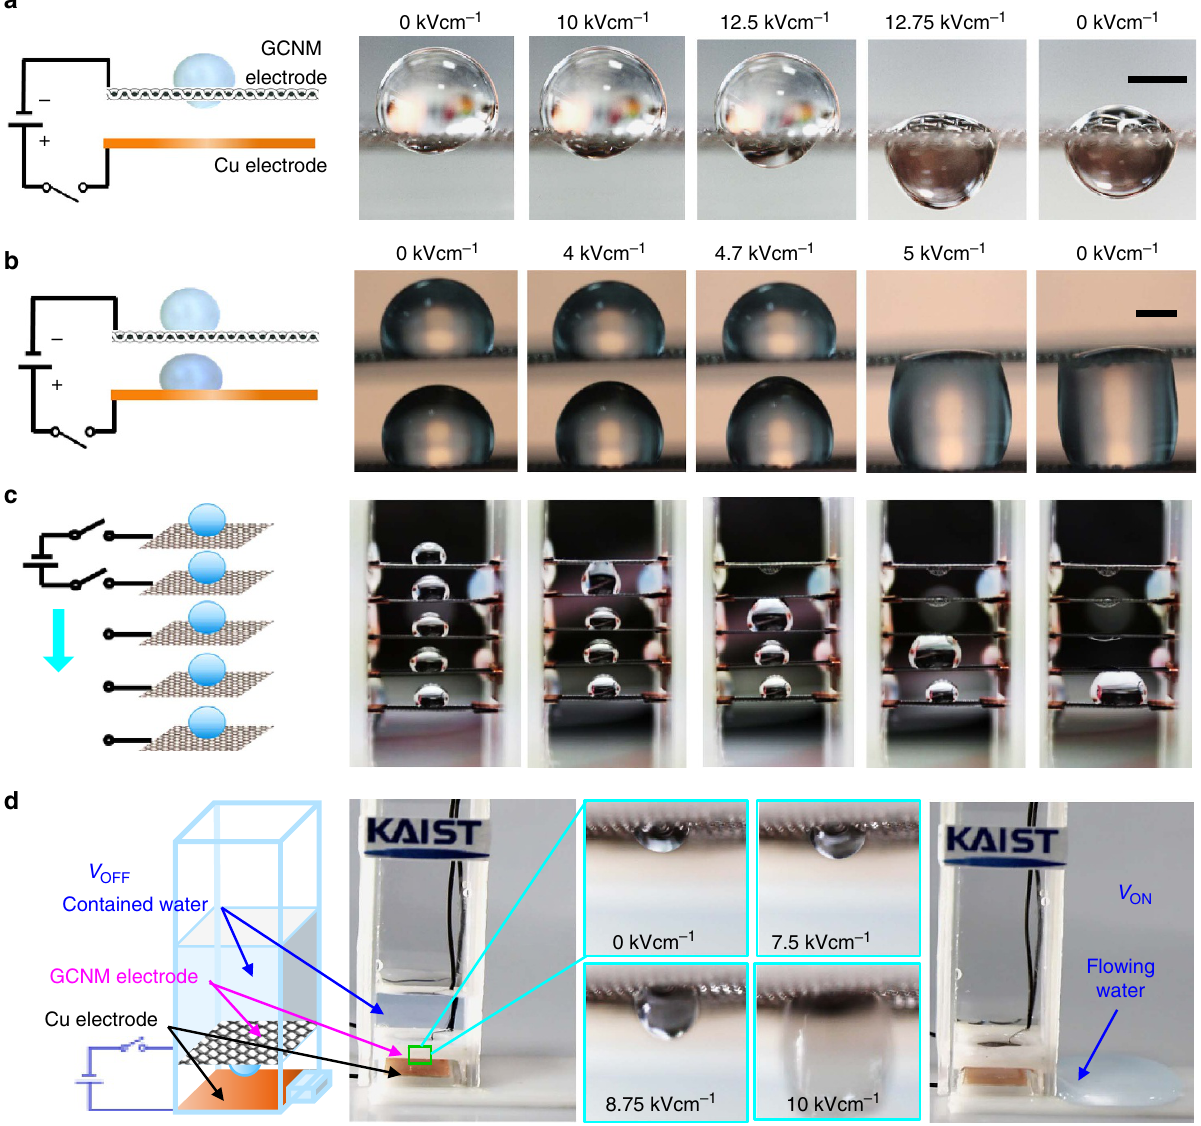
Figure 5 | Irreversible actuation modes and functionally antagonistic active flow devices. ( a ) Irreversible actuation of water droplets on both sides of the mesh. Scale bar, 1mm. ( b ) Irreversible actuation of two water droplets placed on different electrodes. Scale bar, 1mm. ( c ) Locomotion of water droplets on multi-stage GCNM electrodes, and ( d ) Electroactive flow switching device based on